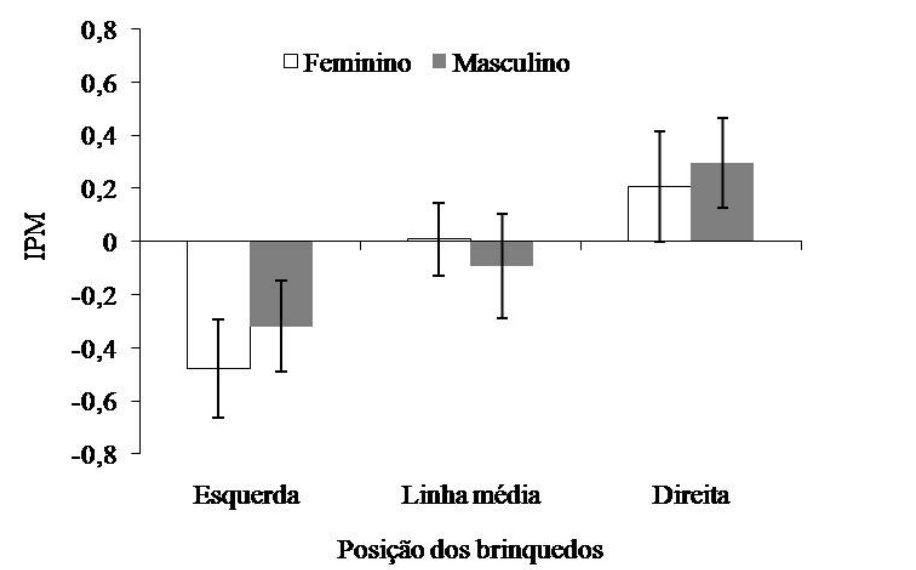
Figura 3 . Índices médios de preferência manual (IPM) observados em função do sexo e da posição do brinquedo Nota . Erro padrão representado por traços verticais.